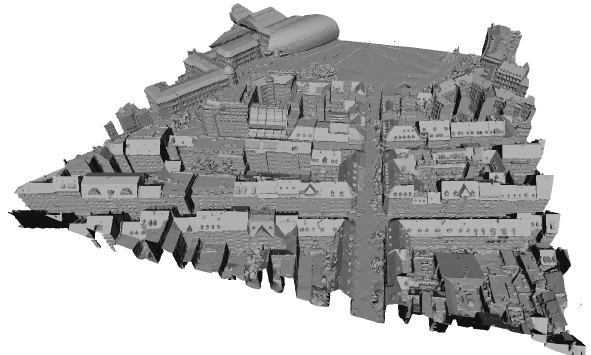
Figure 1. Virtual environment from Strasbourg open dataset